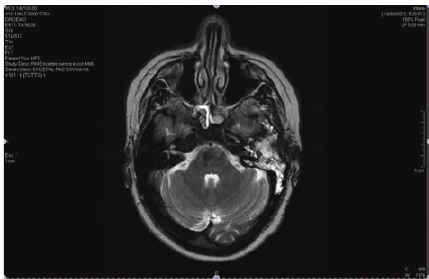
Figure 1: MRI revealing left mastoid cells and the middle ear occupied by a soft tissue density mass.